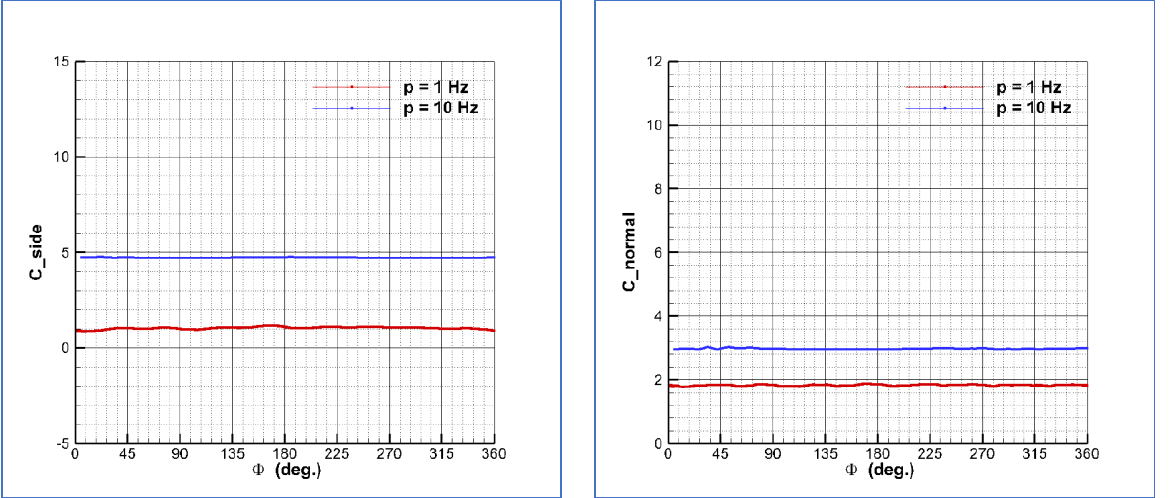
Figure 11. Side ( left ) and normal ( right ) force coefficients versus roll angle at the two positive spin velocities. Last cycle. Ma = 0.2, Re =2 × 10 6 and α = 20 deg.